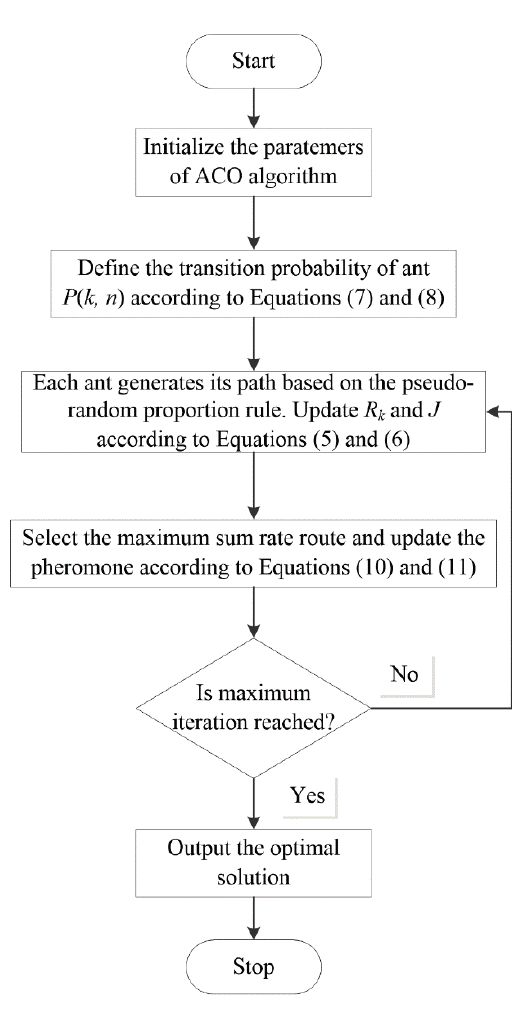
Figure 3. The flow diagram of subcarrier allocation by ACO